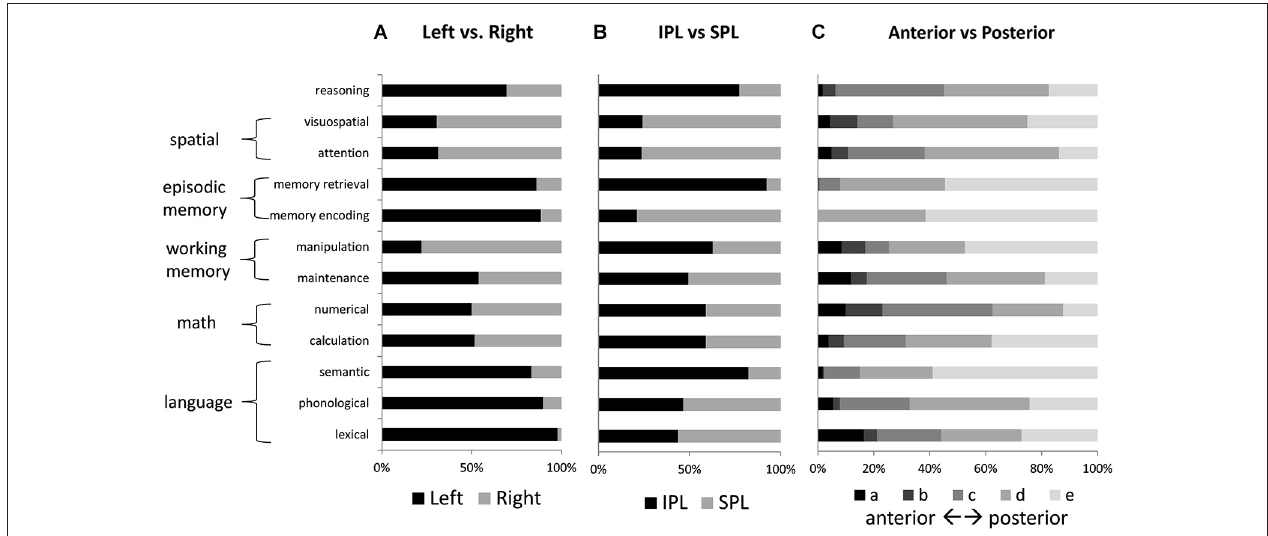
FIGURE 4 | Relative activation volumes associated with each term, for (A) left vs. right parietal cortex, and (B) IPL vs. SPL; and (C) anterior to posterior parietal cortex . All bars add up to 100%. Terms are grouped according to the higher-level category to which they are thought to correspond.